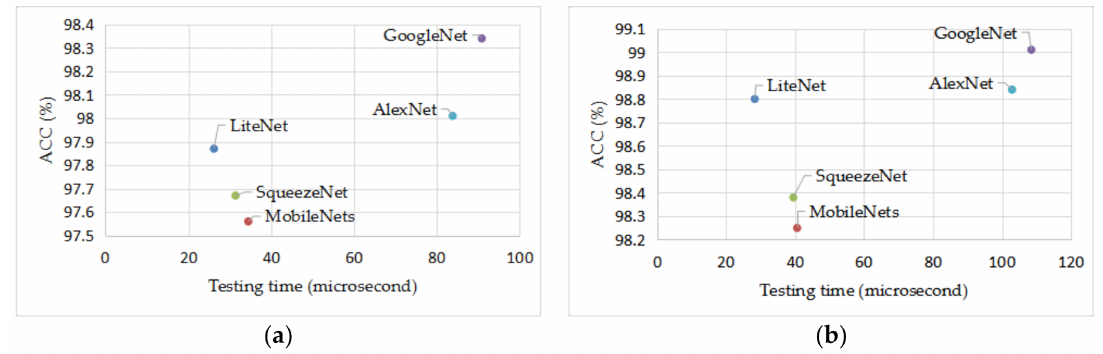
Figure 9. The trade-off between accuracy and testing time on five models. ( a , b ) represent dataset A and dataset B,